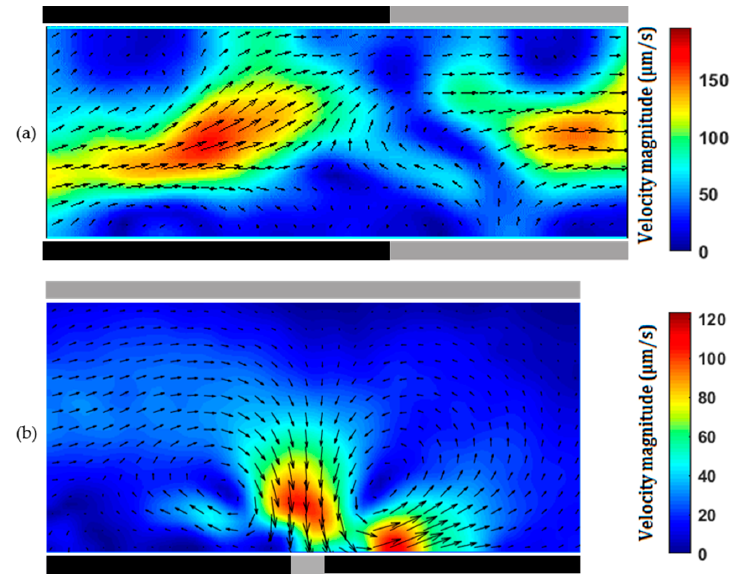
Figure 6. ( a ) Combination of a pressure-driven flow with a volume flow rate of 12 µL/h and ACEO flow between two 0.5 mm pencil-lead electrodes facing each other in a microchannel of 0.3 mm diameter with an AC voltage of 40 V p-p at 50 kHz; ( b ) combination of a pressure-driven flow with a volume flow rate of 6 µL/h and ACEO flow in a microchannel of 0.3 mm diameter with two parallel 0.3 mm pencil-lead electrodes between which the gap is 40 µm. The applied AC voltage on the electrodes is 40 V p-p at 50